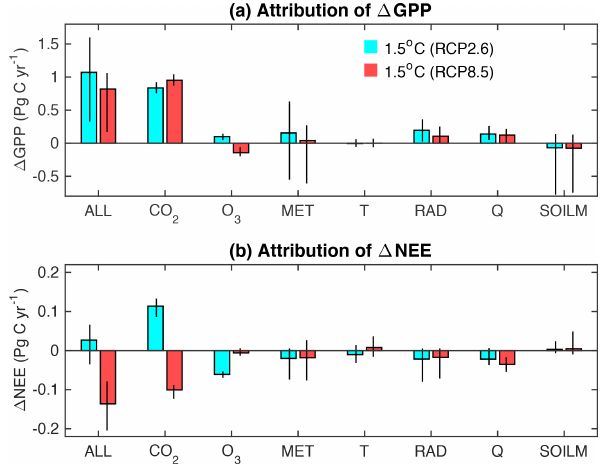
Figure 6. Attribution of changes in GPP and NEE to individual driving factors. Results shown are the predicted GPP changes in China between the period of global warming of 1.5 ◦ C and present day (1995–2015) caused by all (ALL) or individual driving fac- tors, including CO 2 fertilization, O 3 damage, and meteorological changes (MET). The perturbations from meteorology is a combina- tion of those of temperature ( T ), radiation (RAD), specific humid- ity ( Q ), and soil moisture (SOILM). The contrast is shown between the scenarios of RCP2.6 (blue, 2050–2070) and RCP8.5 (red, 2021– 2041). The error bars indicate uncertainties of YIBs simulations us- ing different future meteorology from seven CMIP5